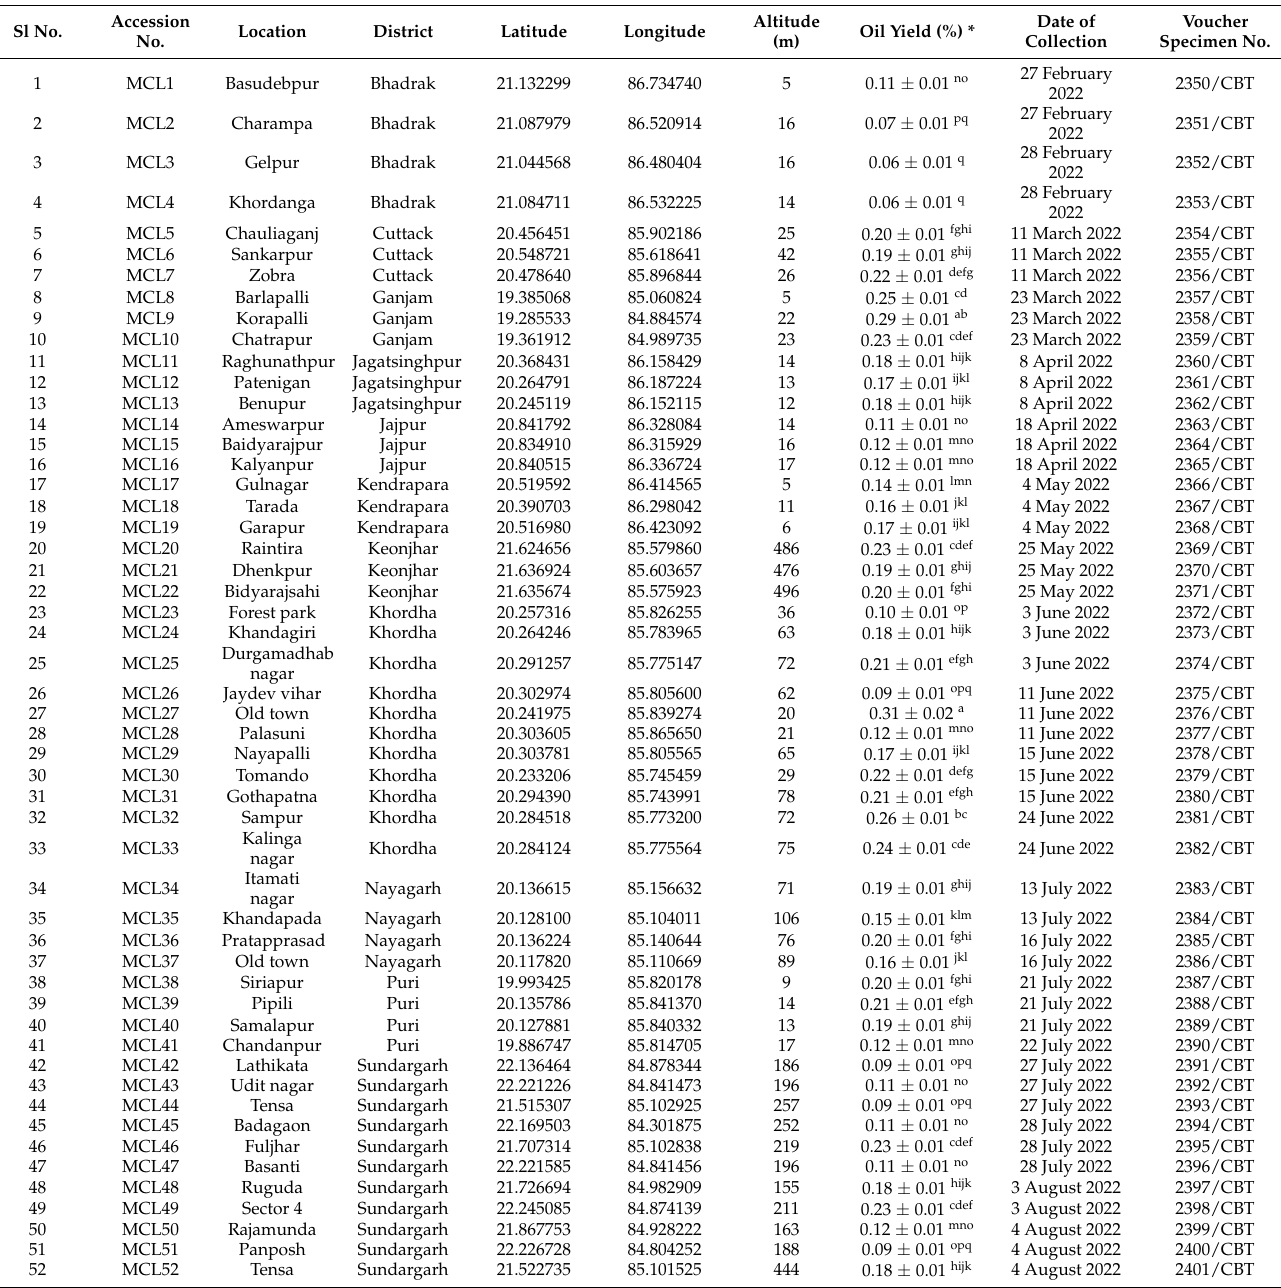
Table 1. Geographical characteristics and essential oil yield of collected M. champaca